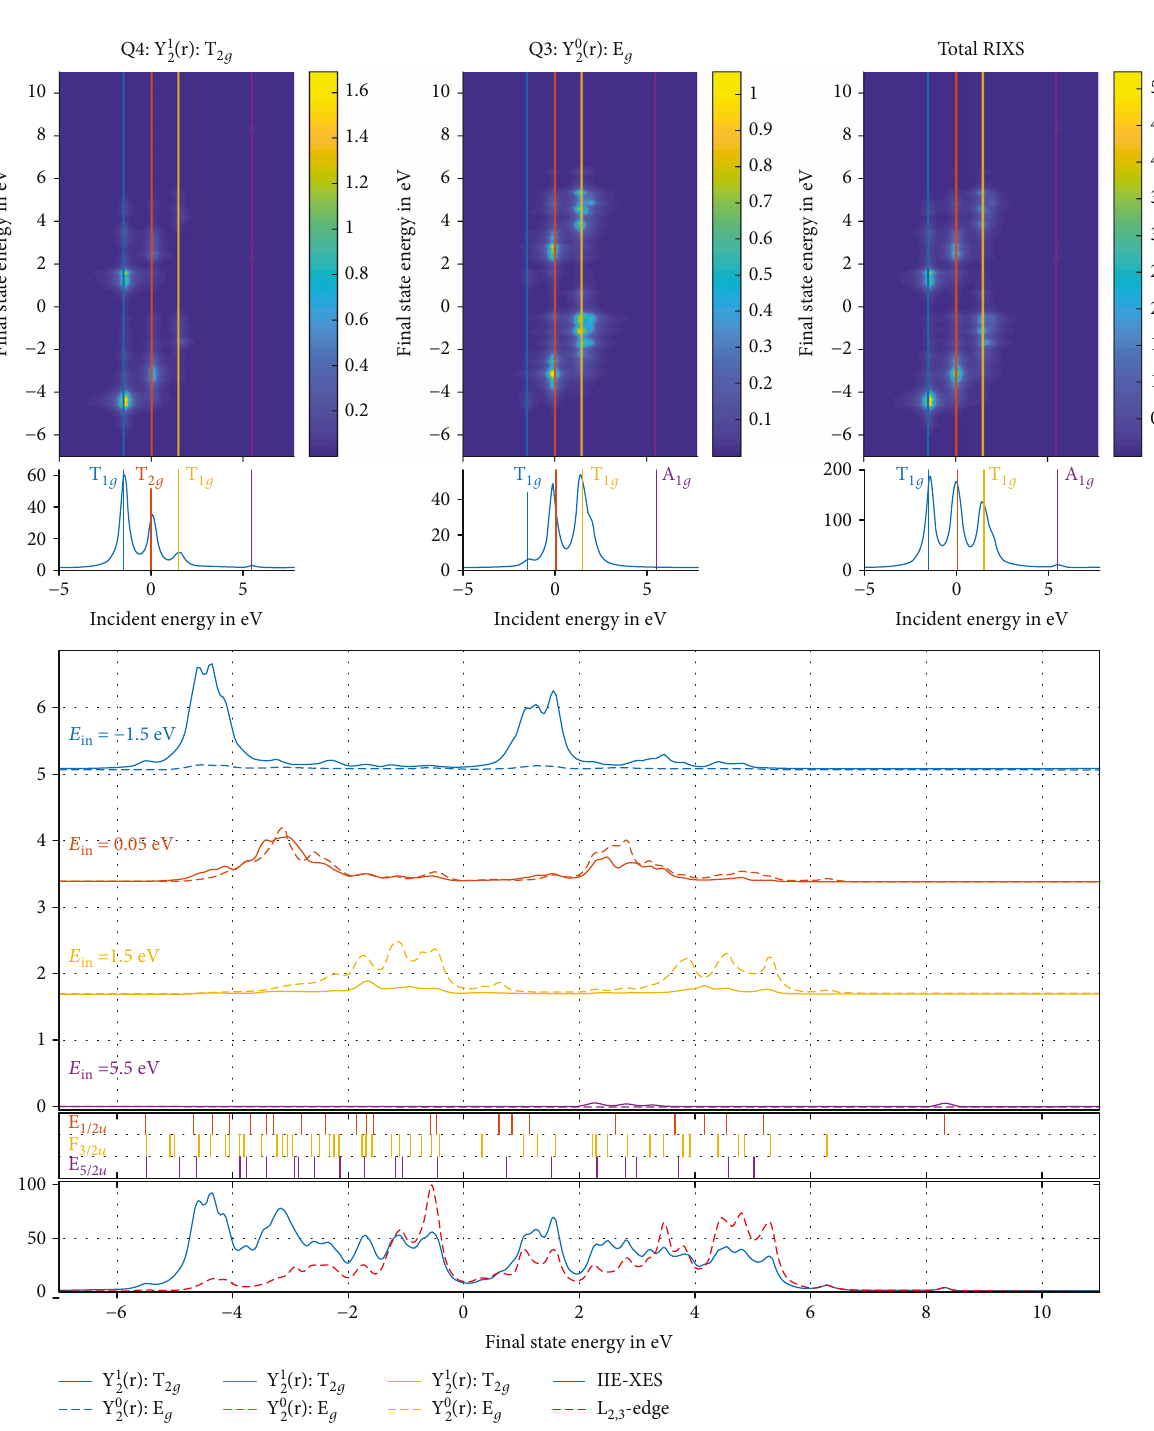
, F , and E with respect to the 1/2 u 3/2 u 5/2 u